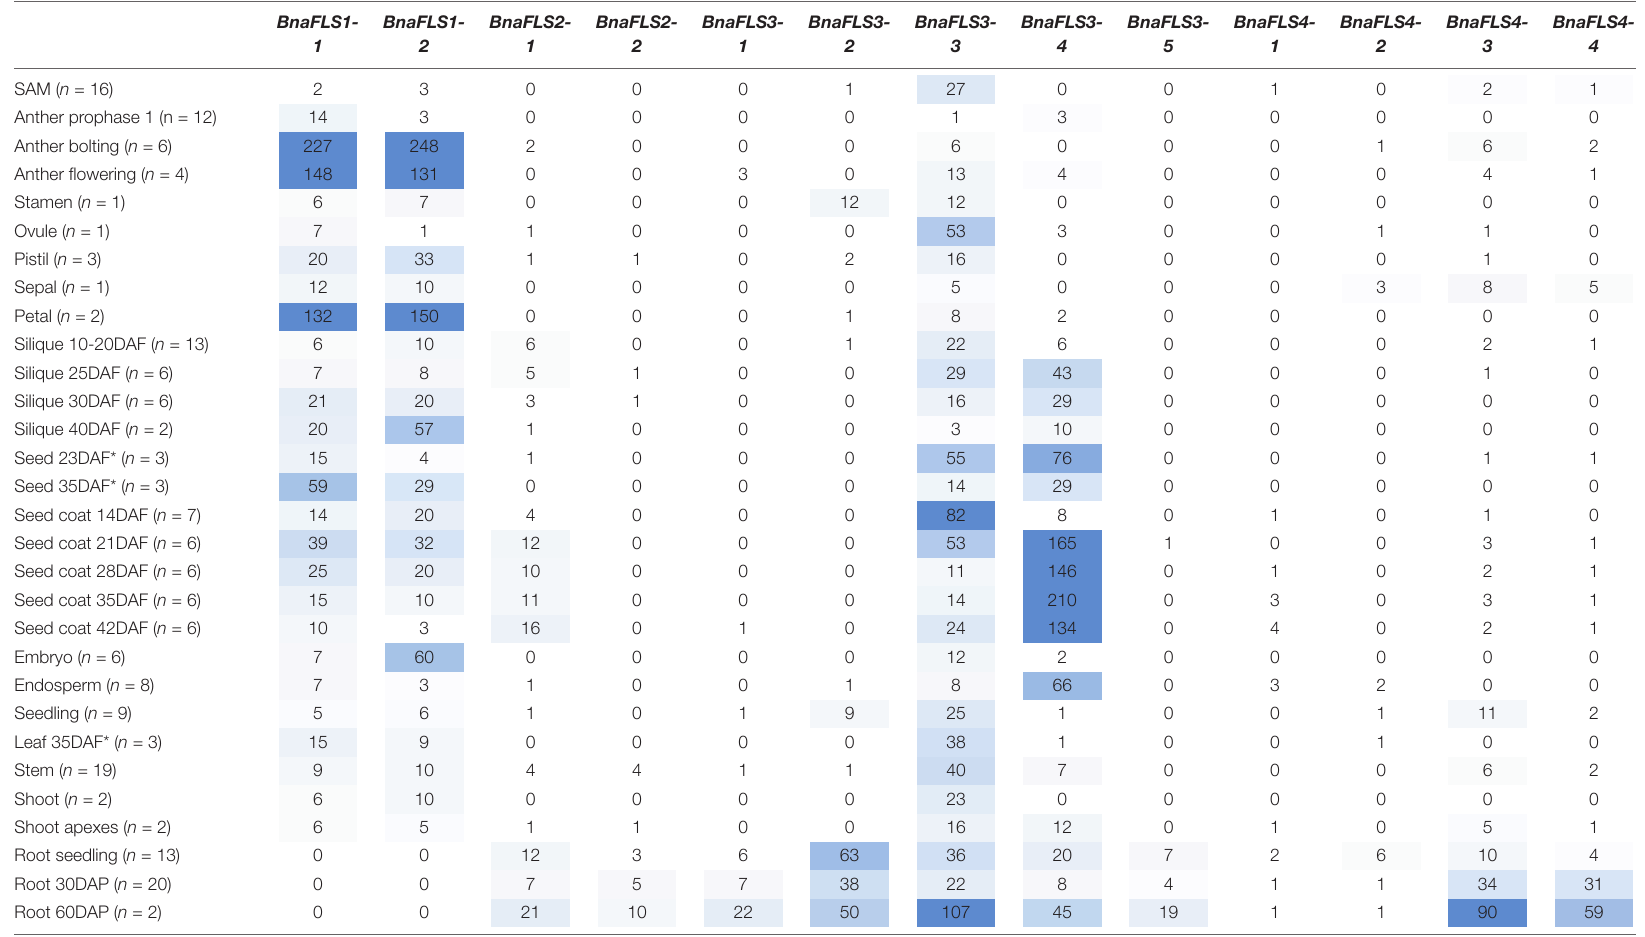
TABLE 2 | Organ-specific expression of BnaFLS candidate